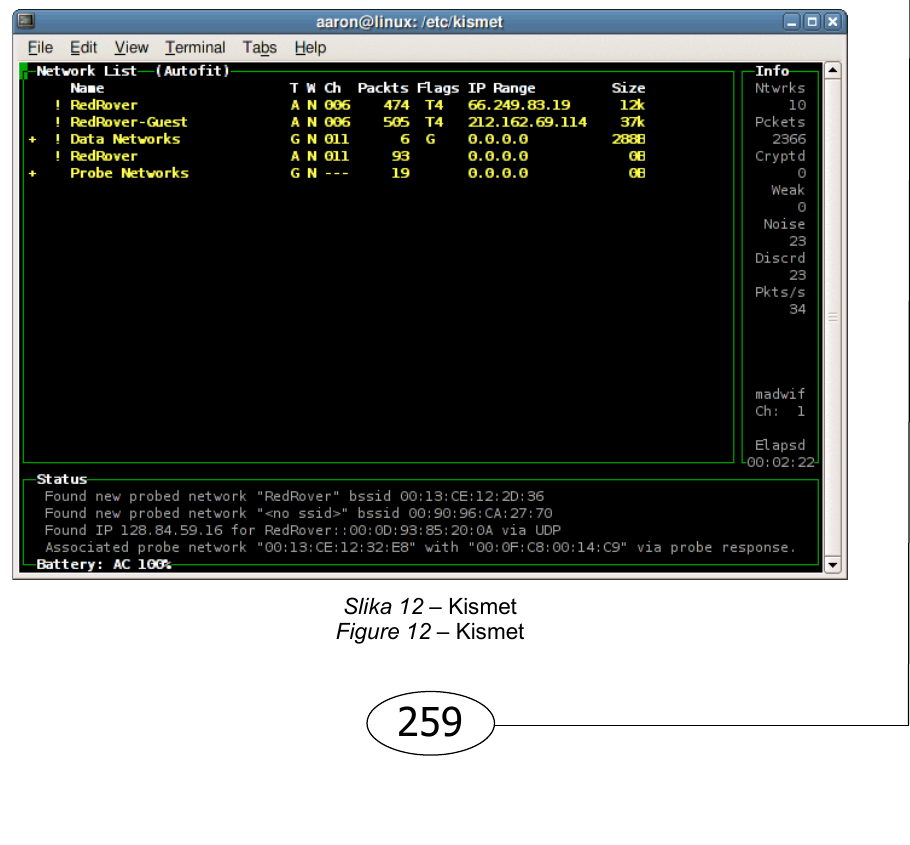
Slika 12 – Kismet Figure 12 –